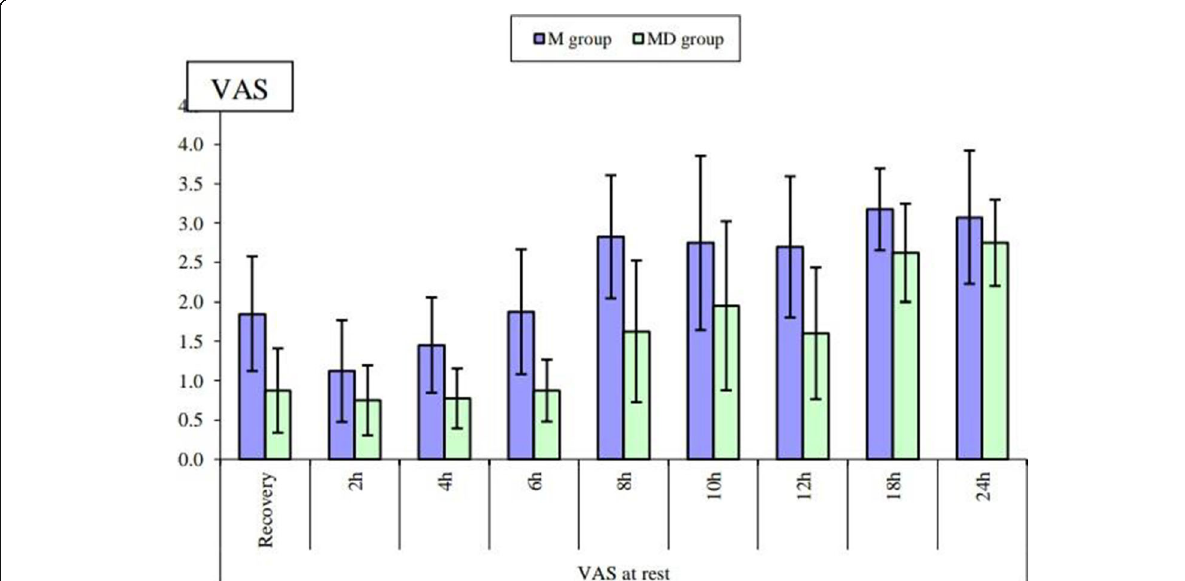
Fig. 2 The mean and SD of VAS at movement within 24 h in the M group and the MD group. Numerical variables are presented as means and standard deviations (independent t